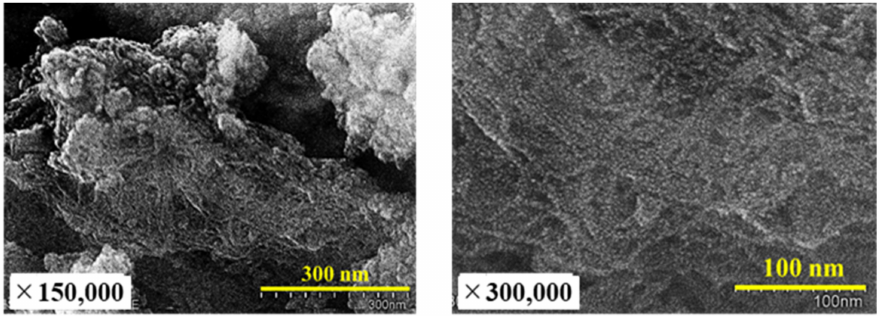
Figure 8. SEM images of the surface structure of